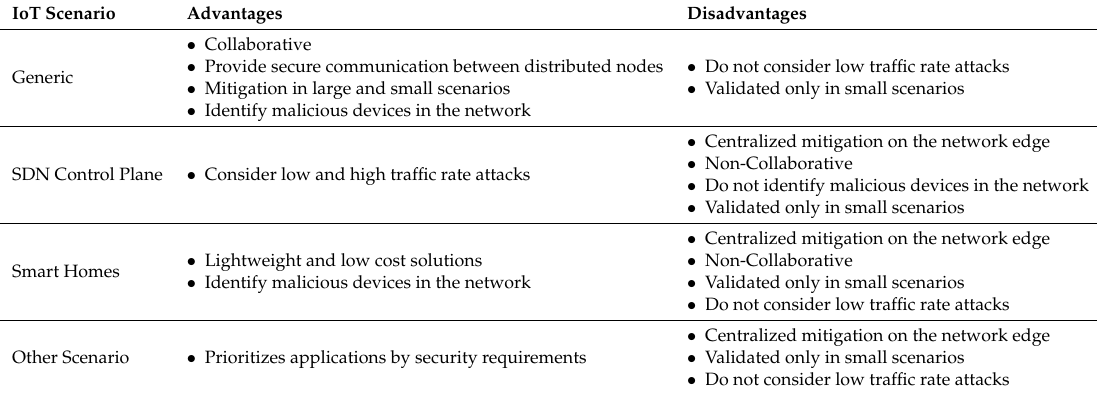
Table 6. Comparison between IoT scenario domains through advantages and disadvantages